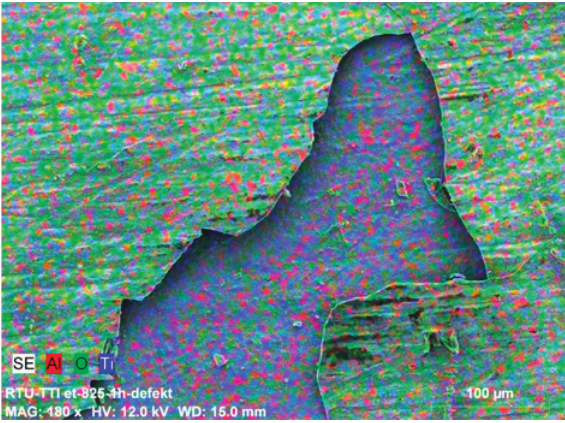
fig. 13. Delamination of oxide layer on a reference sample (without